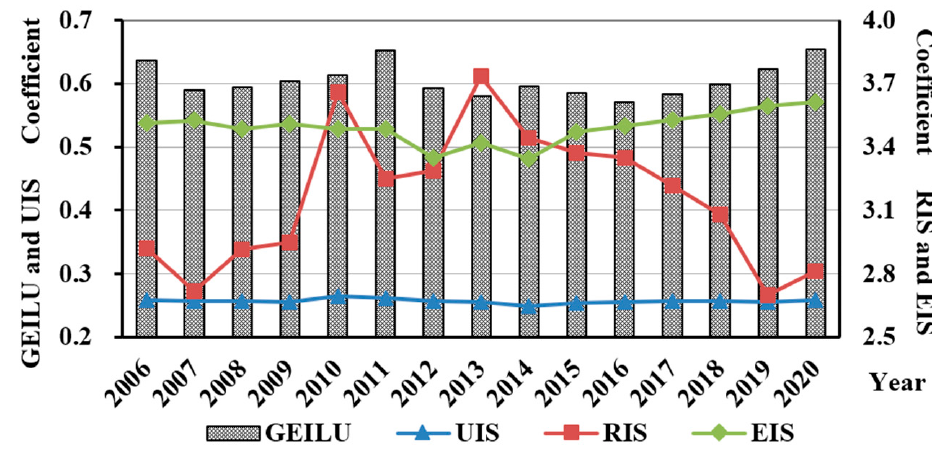
Figure 4. The annual average values of GEILU, RIS, UIS, and EIS.